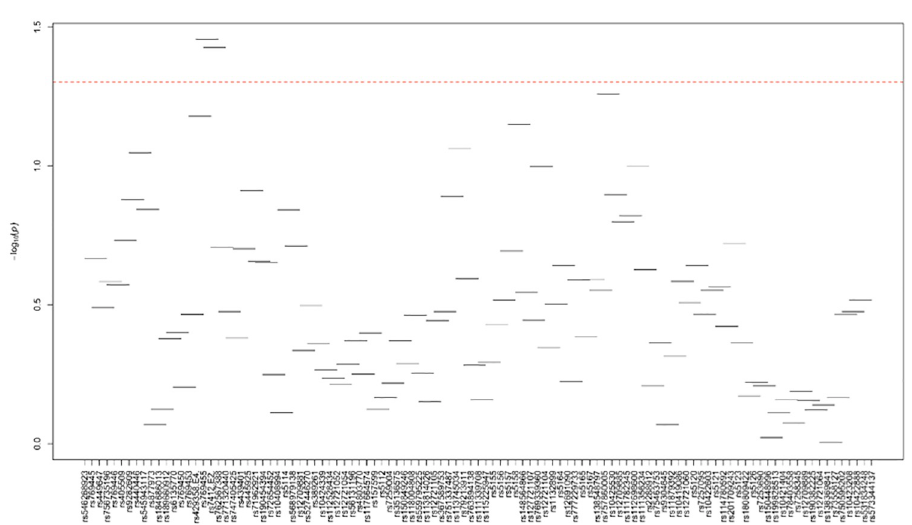
Fig 13. Plots of haplotype-based association analysis results for ApoB in African blacks. Horizontal lines represent the 4-SNP windows. X-axis shows the SNPs genotyped in the regions based on the order of APOE , APOC1 , HCR1 , HCR2 , APOC4 and APOC2 while the Y-axis shows the–log (global p-value) with red line representing the p-value threshold (P = 0.05).